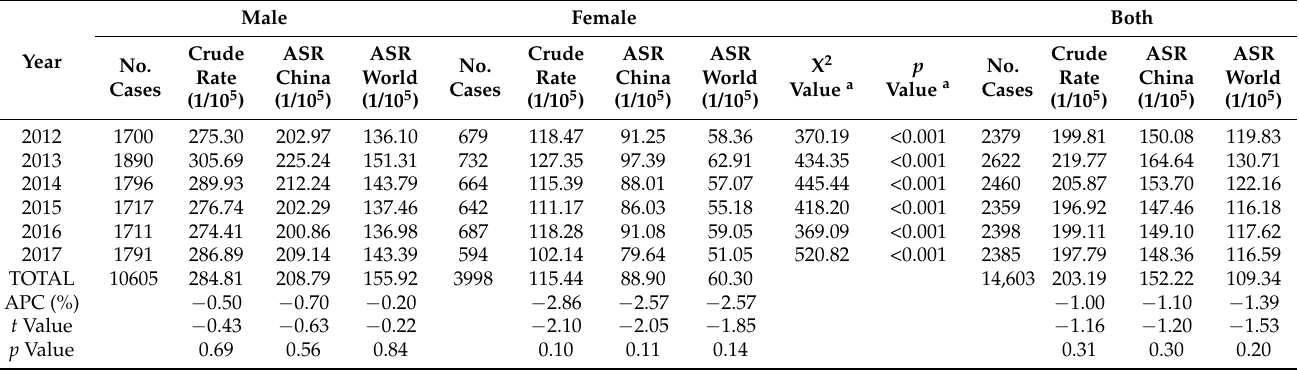
Table 1. Basic situation of digestive tract cancer in residents in Lujiang County from 2012 to